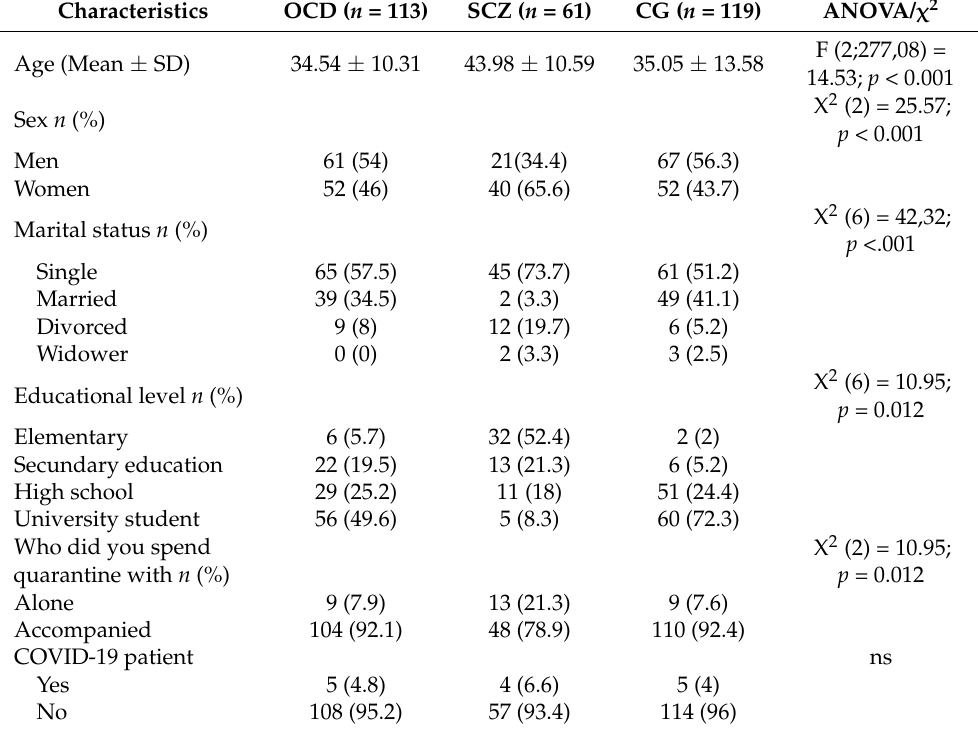
Table 1. Sample characteristics